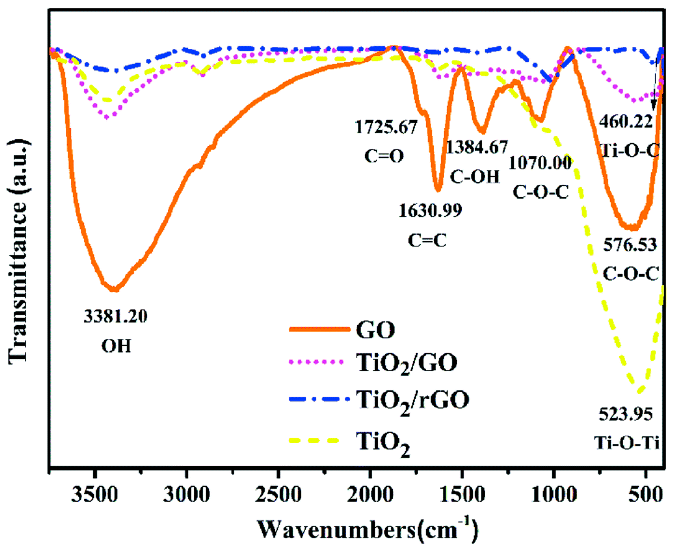
Figure 5. FTIR spectra of as − obtained GO and TiO 2 , and of the corresponding TiO 2 composites after the incorporation of GO or RGO [148] (Reprinted with permission from [148] Copyright 2018 Royal Society of Chemistry).